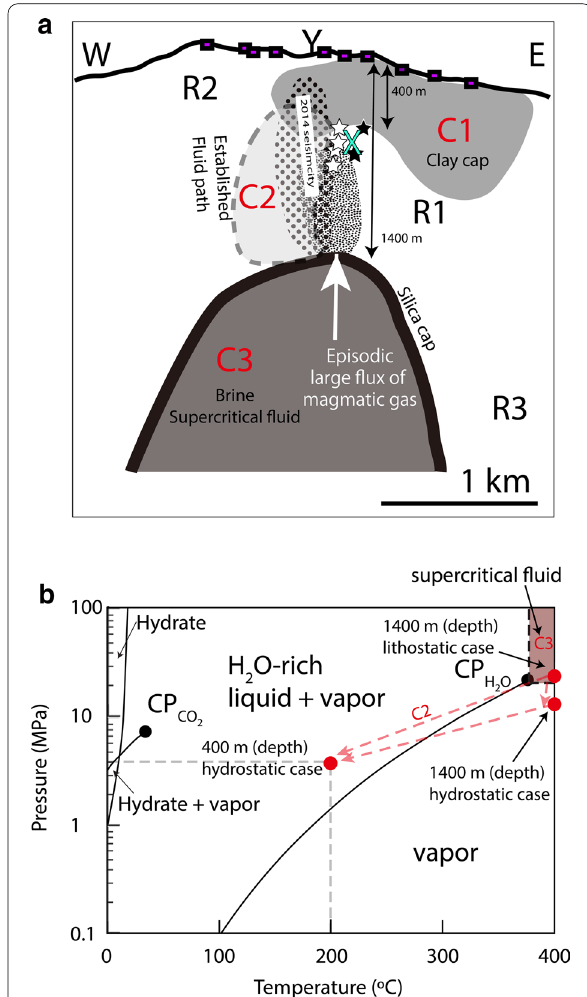
Fig. 5 a Simplified W–E resistivity section in Fig. 4b. The rectangles on the terrain denote the observation sites. The white and black stars and the green “X” symbols are the same as in Fig. 4. The swarm dots with bigger and with smaller circles denote the hypocenters of microseismic events during 2014 unrest, and out of this active period, respectively. b Pressure–temperature projection of hydrothermal fluid phase diagram for H 2 O and CO 2 (after Hutnak et al. 2009). Two curves which end with solid circles denote the liquid–vapor coexistence curves of pure CO 2 and pure H 2 O with their critical points (CP). C2 may be an established fluid path from the supercritical fluid. In contrast, if episodic large gas flux breaks the silica cap, breakage of the silica cap may flush the fluid upward in the hydrostatic